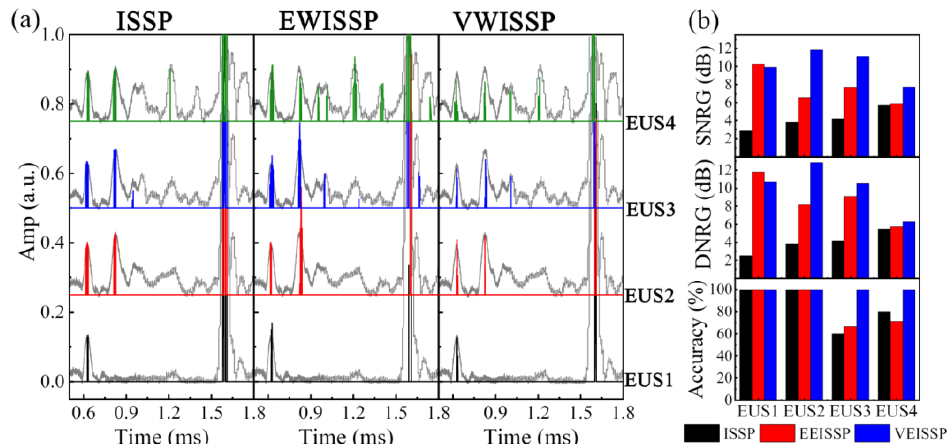
Figure 17. ISSP, EWISSP and VWISSP processing results of EUS 1 to 4: ( a ) sparse signals, ( b ) SNRGs, DCRGs and accuraies.